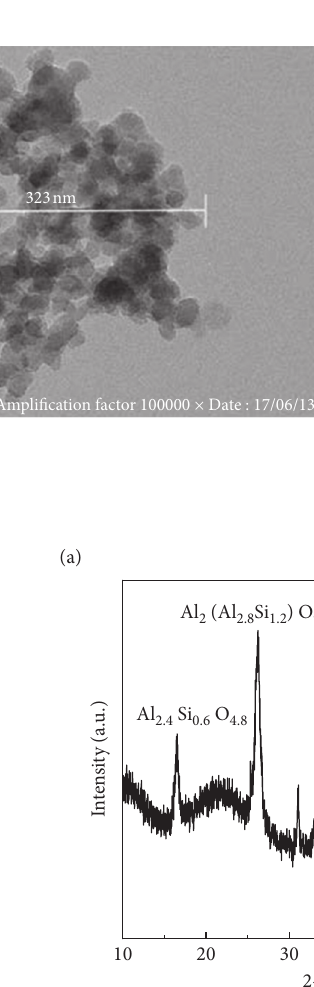
Figure 1: Chemical composition and weight percentages of the ordinary Portland cement and the SMK.